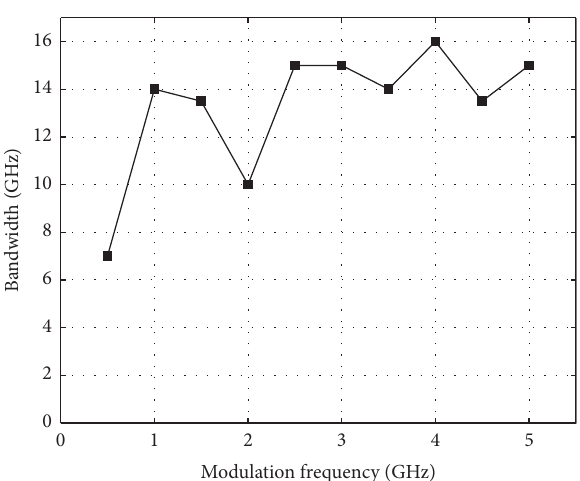
Figure 5: Effect of modulation frequency on MFC.